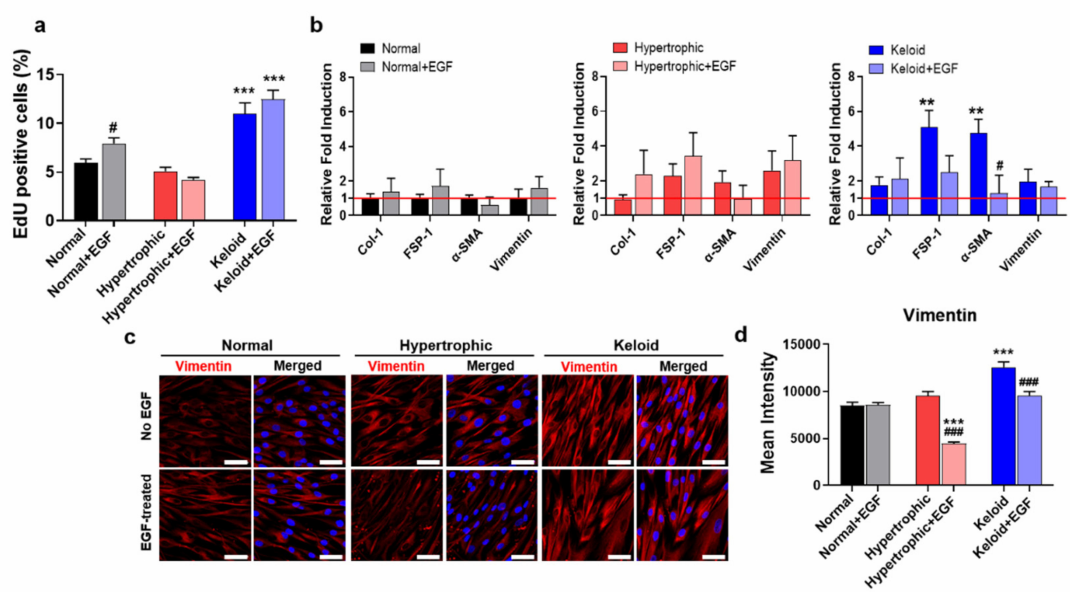
Figure 5. Exogenous EGF-mediated amelioration of the fibrotic phenotypes of keloid dermal fibroblasts. ( a ) Flow cytometry analysis of EdU-positive cells. ( b ) qPCR of skin fibrosis-/activation of myofibroblast-associated markers in the presence or absence of EGF treatment. Data were normalized against those of normal fibroblasts without EGF treatment. The red solid line represents gene expression in the control group (normal dermal fibroblasts). Data represent the mean ± SEM. ** p < 0.01, *** p < 0.001 vs. normal fibroblasts without EGF treatment; and # p < 0.05, vs. each control. ( c ) Immunofluorescence staining of vimentin (red) and nuclei (blue). Scale bar = 50 µ m. ( d ) Mean intensity values of vimentin protein expression quantified by MATLAB. Data represent the mean ± SEM. *** p < 0.001 vs. normal fibroblasts without EGF treatment; and ### p < 0.001 vs. each